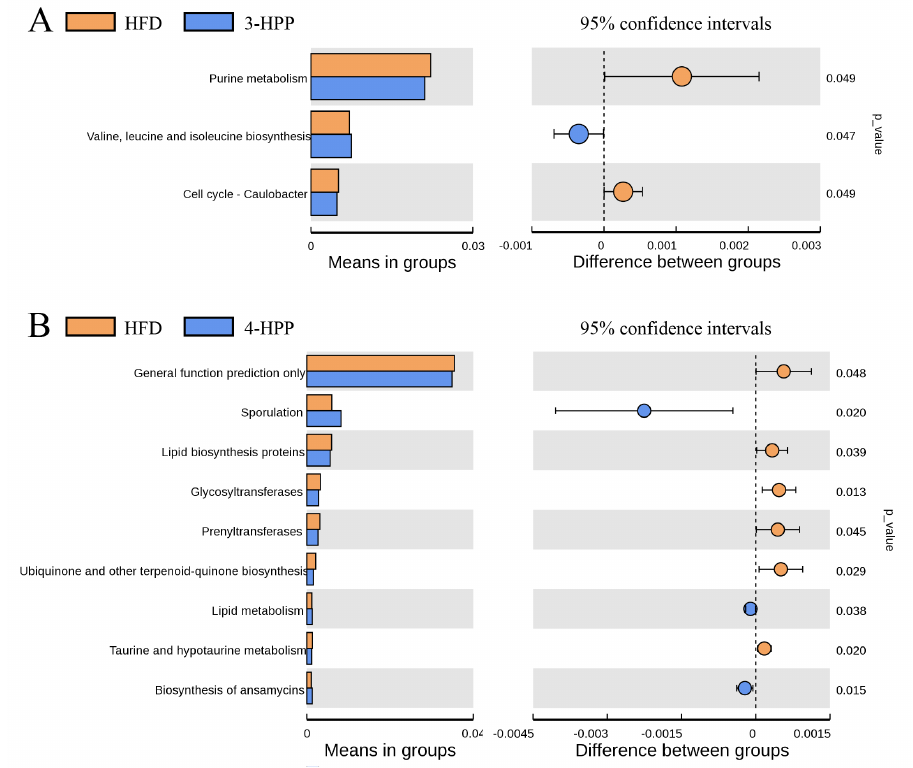
Figure 7. The effects of 3 − HPP and 4 − HPP on the predicated metabolic profile of gut microbiota. ( A ) Comparison between HFD and 3 − HPP. ( B ) Comparison between HFD and 4 − HPP. The key metabolic pathways predicted by PICRUSt2 and KEGG were selected based on a t-test at p < 0.05. n = 5 if not specified. The colour of the circle is the same as the group with a higher function. The line segment indicates the 95% confidence interval.